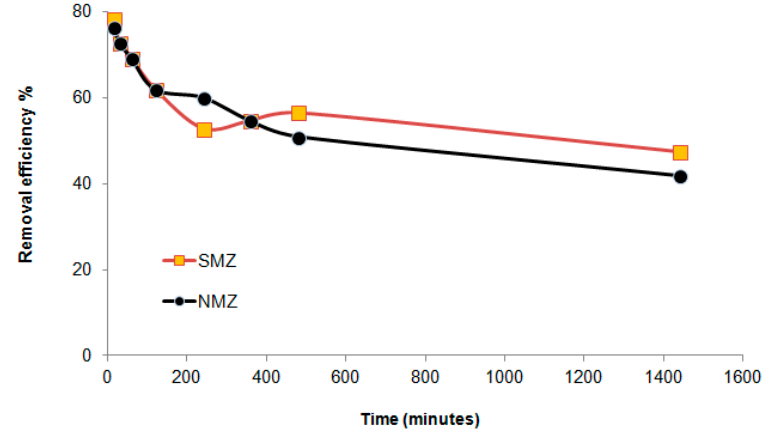
Figure 7. Mo removal efficiency by the surfactant modified and non-modified phillipsite–chabazite tuff as a function of contact time.